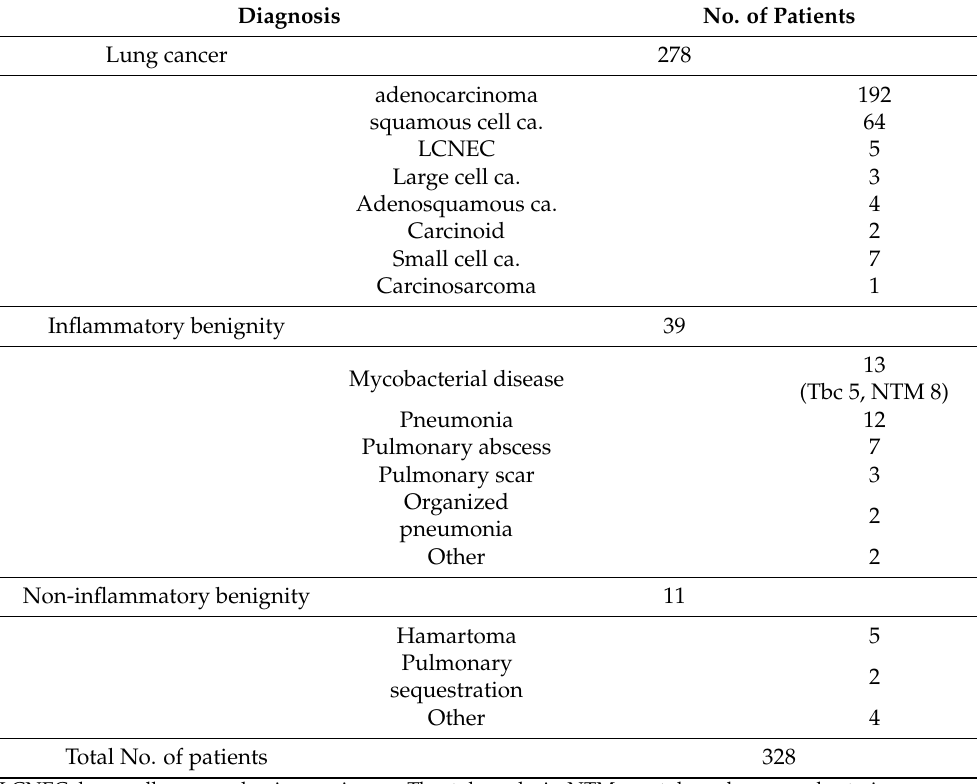
Table 1. Patients’